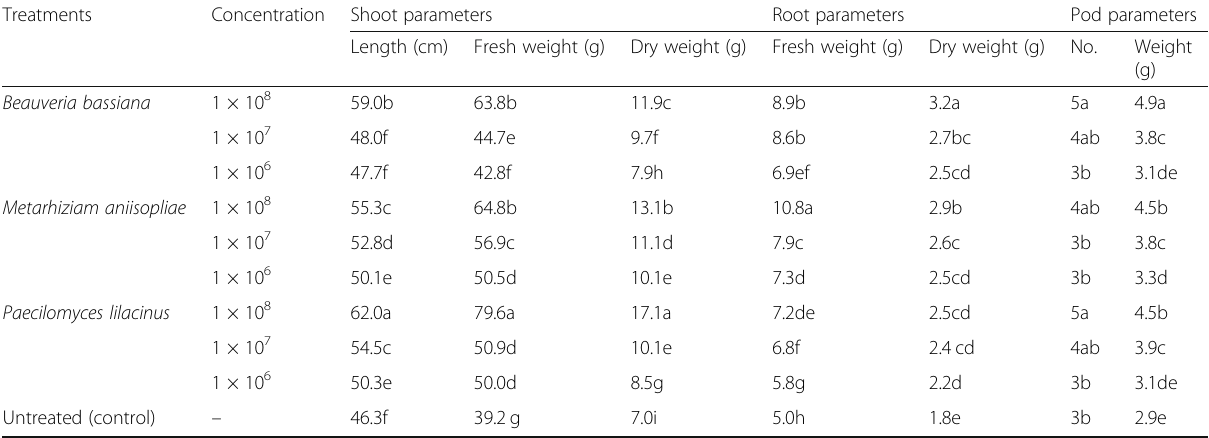
Table 10 Effect of three spore concentrations from Beauveria bassiana , Metarhiziam aniisopliae , and Paecilomyces lilacinus on vegetative parameters and yield of cowpea infected by root-knot nematode, Meloidogyne incognita